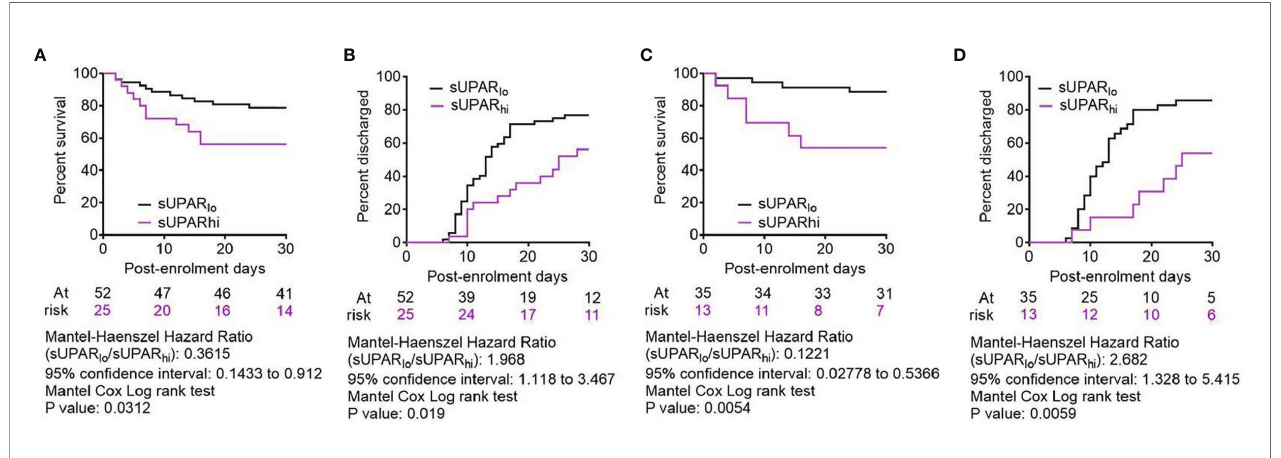
FIGURE 8 | Comparison of clinical outcomes between severe COVID-19 patients with low and high plasma suPAR levels. (A, C) Survival of patients in the two arms from the day of enrolment till day 30 post-enrolment are compared in a Kaplan – Meier curve, for all age groups (A) as well as for patients aged <65 years (C) . Surviving patients were censored on day 30 post-enrolment. (B, D) Hospital stay duration of the patients from both groups (suPAR lo and suPAR hi ) since the day of enrolment is plotted in an ascending Kaplan – Meier curve, for all age groups (B) as well as for patients aged <65 years (D) . Deaths and non-remission at day 30 post-enrolment were censored. For all outcome comparisons, the Mantel – Cox log-rank test was